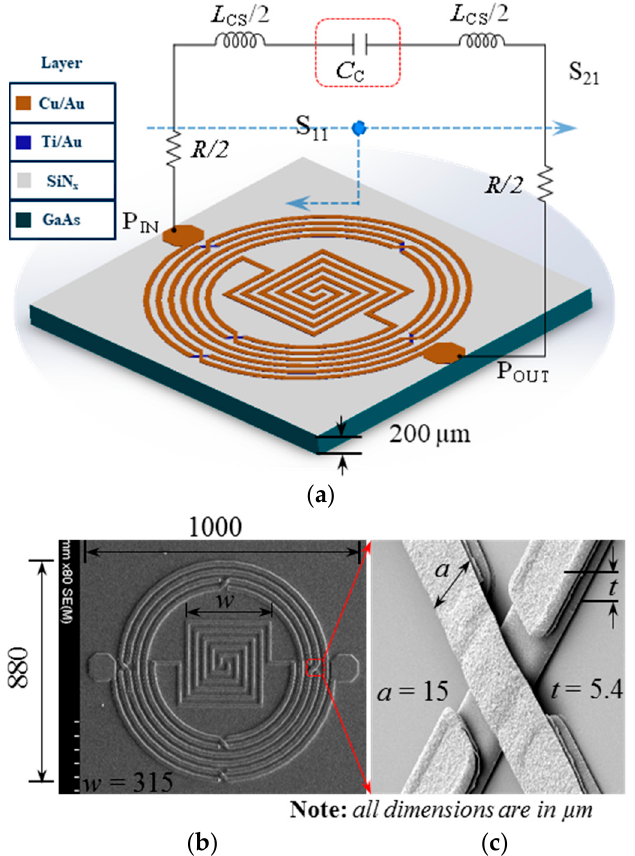
Figure 1. Proposed resonator based on a micro-fabricated air-bridged circular spiral inductor and meandered-line coupling capacitor. ( a ) 3D layout and equivalent lumped-element circuit; ( b ) scanning electron microscopy (SEM) image of fabricated resonator; and ( c ) enlarged focused ion beam (FIB) image of the air-bridge structure.